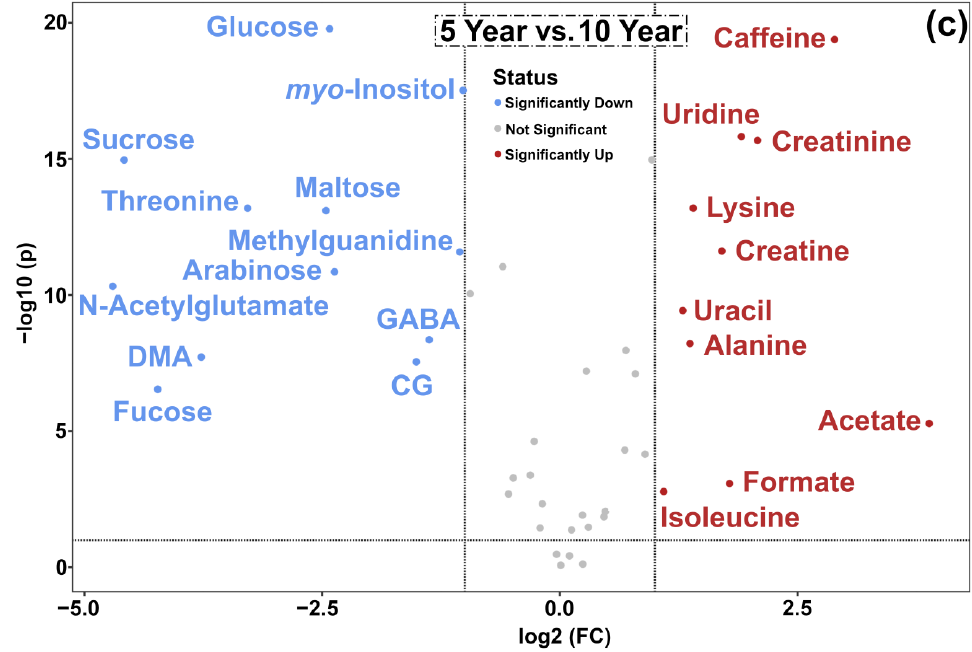
Foods 2022 , 11 , x FOR PEER REVIEW Figure 3. Volcano plot built on the concentration of molecules in each of the two groups. ( a ) indicates 1 Year vs. 5 Year, ( b ) indicates 1 Year vs. 10 Year and ( c ) indicates 5 Year vs. 10 Year.